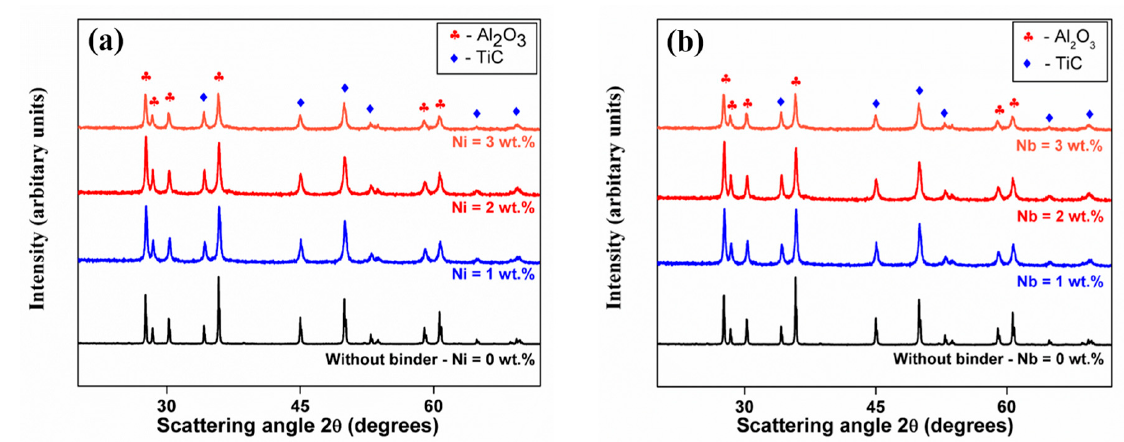
Figure 1. XRD (Cu-K α ) patterns of the Al 2 O 3 -10TiC-milled powder with the different binder content with ( a ) Ni and ( b ) Nb addition.